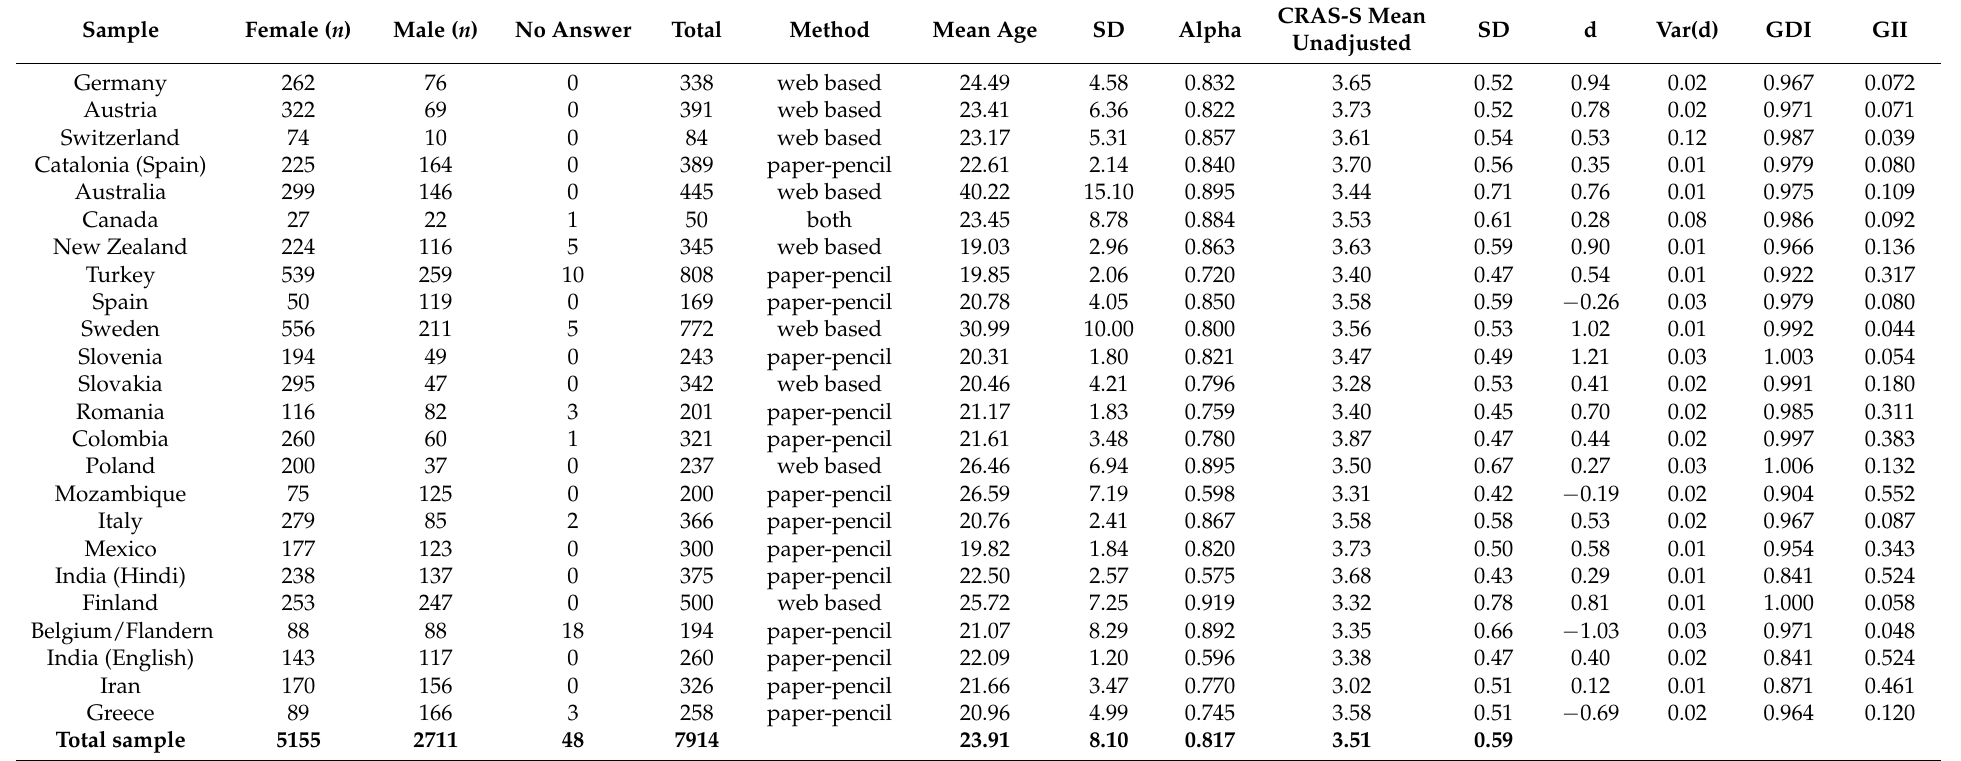
Table 1. Overview over the countries, including sample sizes, gender, age and reliability. Mean scores of the Composite Respect for the Composite Respect for Animals Scale Short version (CRAS-S) are also reported with high values representing high pro-animal attitude. The alpha refers to the unadjusted CRAS-S means. The GDI value is the ratio of the HDI value for women and men. The closer the ratio is to 1, the smaller the gap between women and men. A higher gender inequality index (GII) is related to a higher